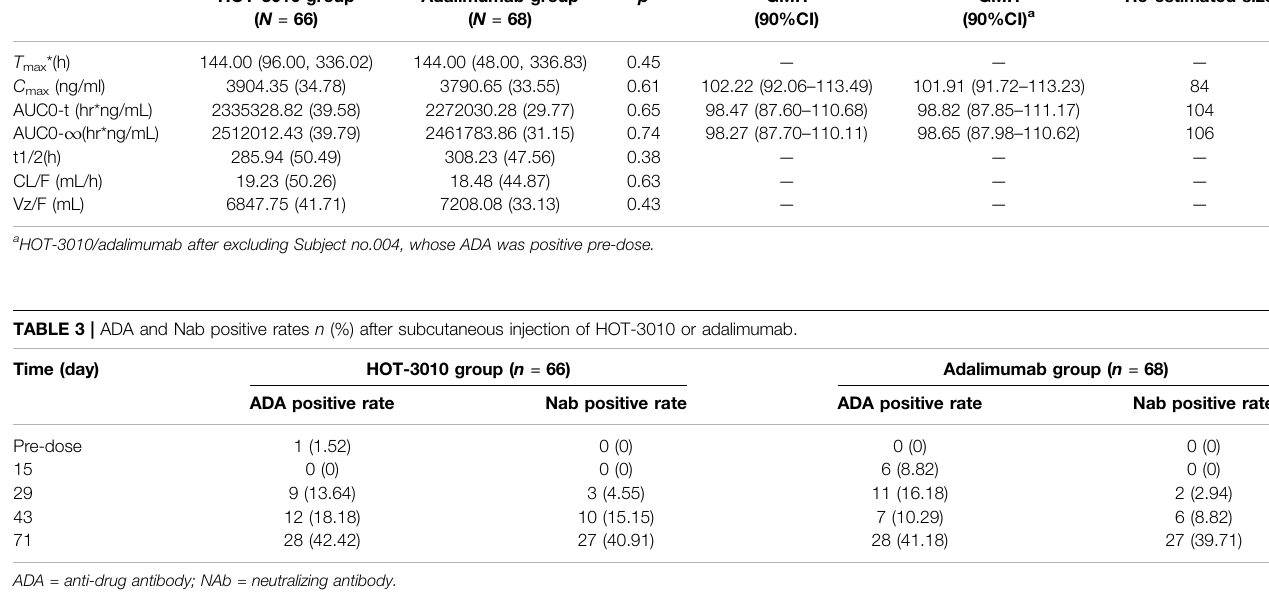
TABLE 2 | Pharmacokinetic parameters of adalimumab in each group (Mean [CV%] or median [min, max]). HOT-3010 group ( N = 66)